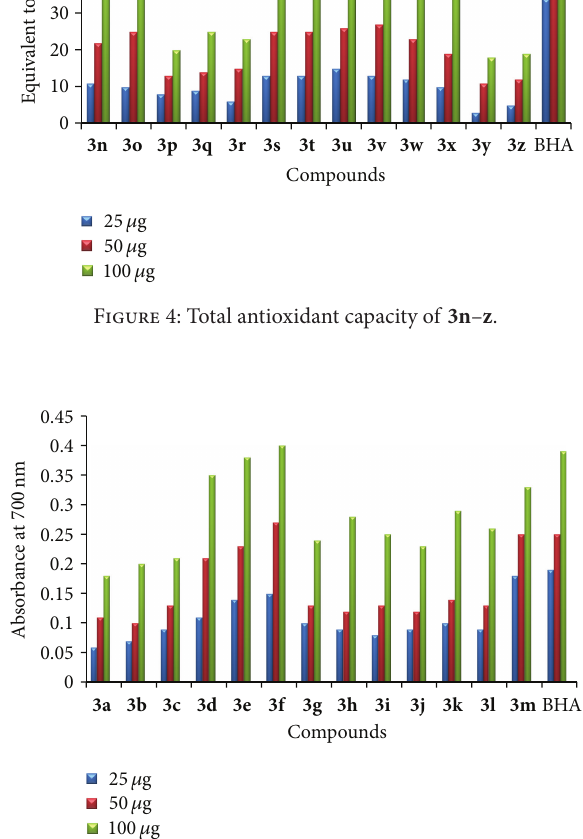
Figure 2: Free radical scavenging activity of 3n – z .